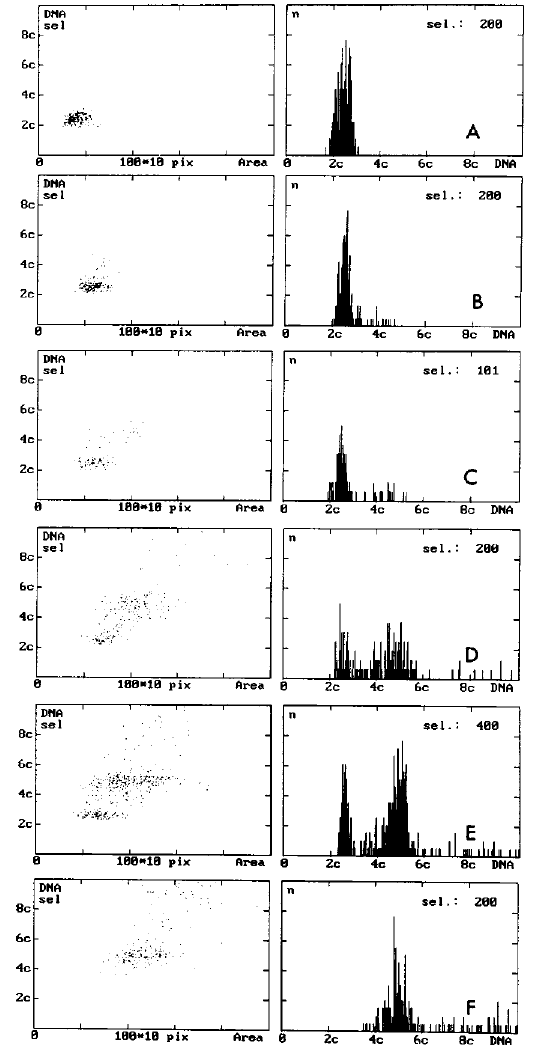
Fig. 2. DNA histograms produced from a prostatic FNAB sample diagnosed as definitely malignant (class 5). As in Fig. 1 the effect of selecting different types of nuclei on the histogram are shown. The control lymphocytes were set at 2c. In Fig. A small epithelial cells were selected between cell groups. In Fig. B medium sized nu- clei were selected. In Fig. C large nuclei were selected between cell groups, cells with clearly distinguishable nucleoli were excluded. In Fig. D large nuclei with clearly distinguishable nucleoli between cell groups were selected. In Fig. E all types of epithelial nuclei between cell groups and epithelial nuclei at the periphery of cell groups (all cells without nuclear overlap) were selected. In Fig. F that large nu- clei between and at the periphery of cell groups were selected. The numbers of cells selected for analysis are shown in the panels on the